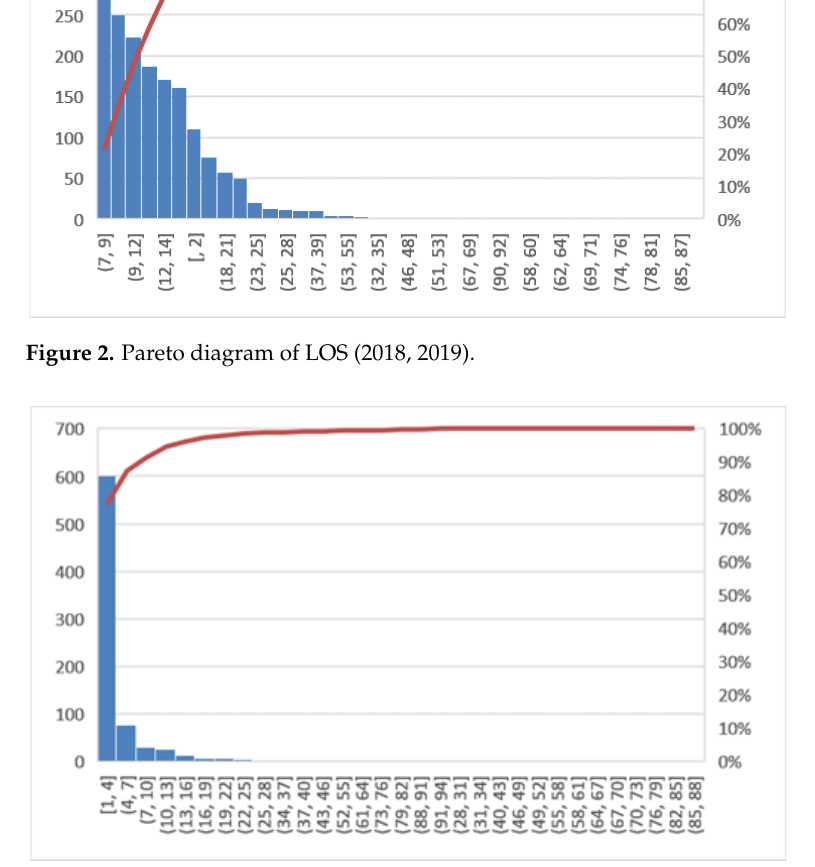
Figure 5. The run chart of total LOS for stroke patients before COVID-19. The orange line indicates the average value of 11.19 days. 2.2.4. Improve Only after having collected and examined all the objective evidence is it possible to move on to the actual improvement phase. The purpose of this phase is to design the most suitable solution to solve the problem we are considering. The COVID-19 emergency, with the necessary social distancing measures and the inevitable fear of the population to go to the hospital or contact local emergency services, has led to a significant decrease in the number of hospitalizations for stroke and therefore, in the number of patients treated compared to the numbers from the same period in the previous year. The COVID-19 emergency has suddenly changed the geography of the stroke units: stroke is a health emergency but, even during the pandemic, high-level treatment was guaranteed. The Campania region of Italy has reorganized the stroke network based on the num- ber of hospitalizations for stroke by province and the respective population density, es- tablishing three second-level stroke units and four first-level stroke units for the province of Naples and one second-level stroke unit for each of the remaining provinces. An addi- tional first-level stroke unit, based on population density, has also been established [64].